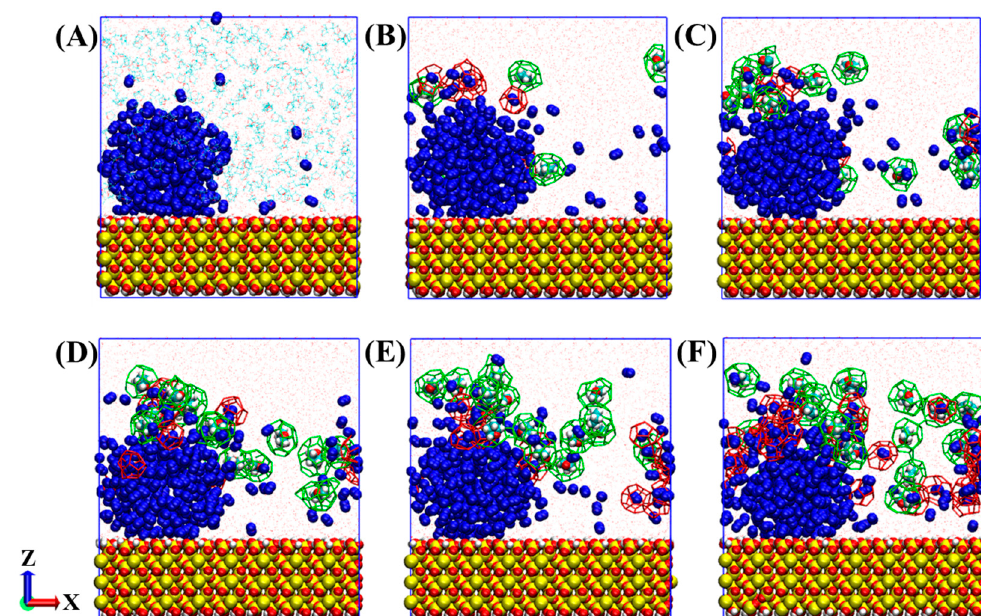
Figure 3. Formation process of hydrates in a system with a nitrogen bubble: ( A ) 0 ns, ( B ) 100 ns, ( C ) 200 ns, ( D ) 400 ns, ( E ) 800 ns, and ( F ) 2000 ns. Isolated THF molecules are not represented in ( B – F ) for a clearer display. The atomic representation is the same as in Figure 1. THF and N 2 cages are represented as green and red stick lines, respectively.